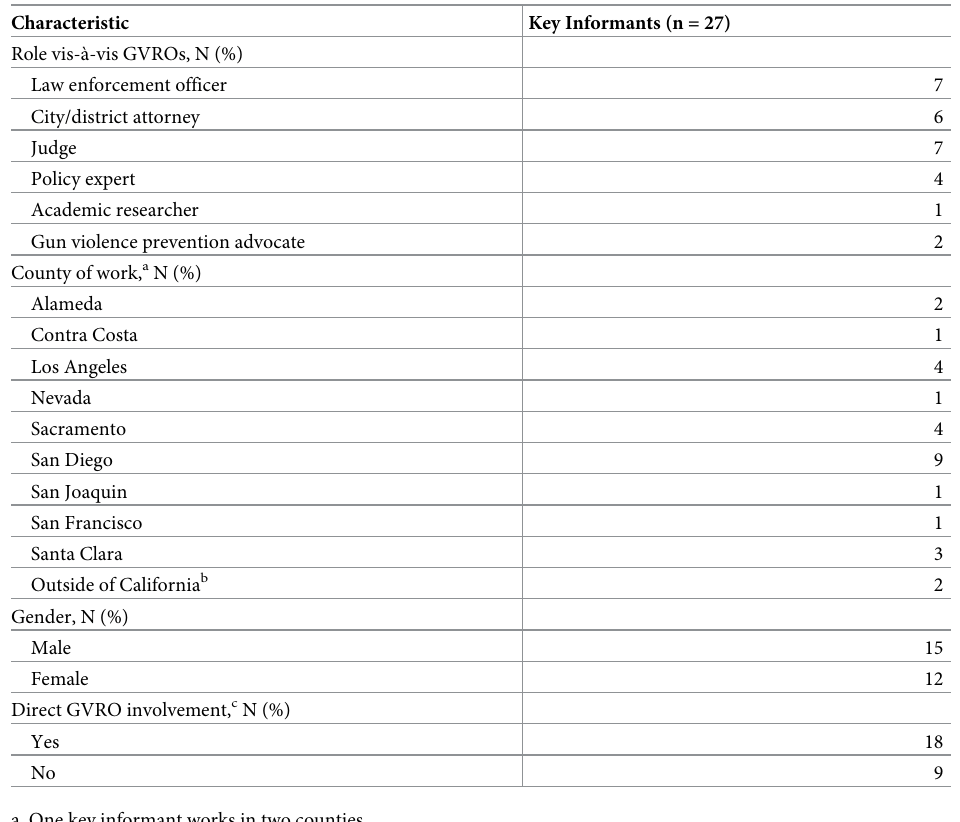
Table 1. Key informant